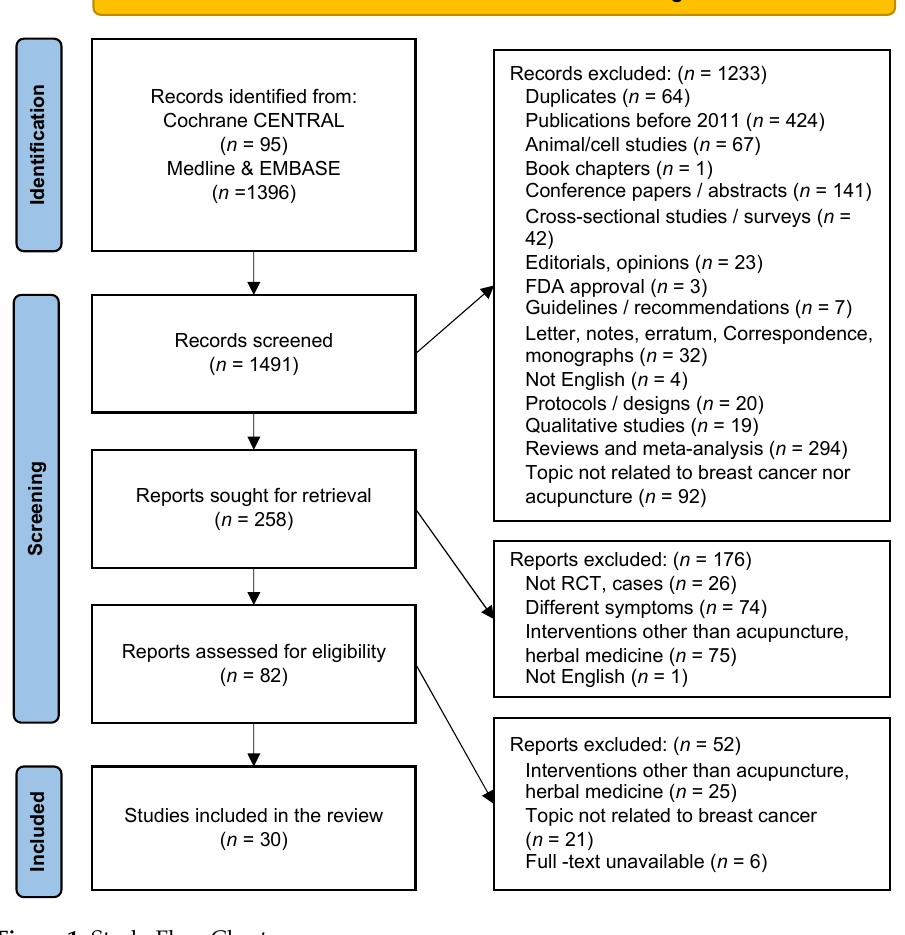
Figure 1. Study Flow Chart.